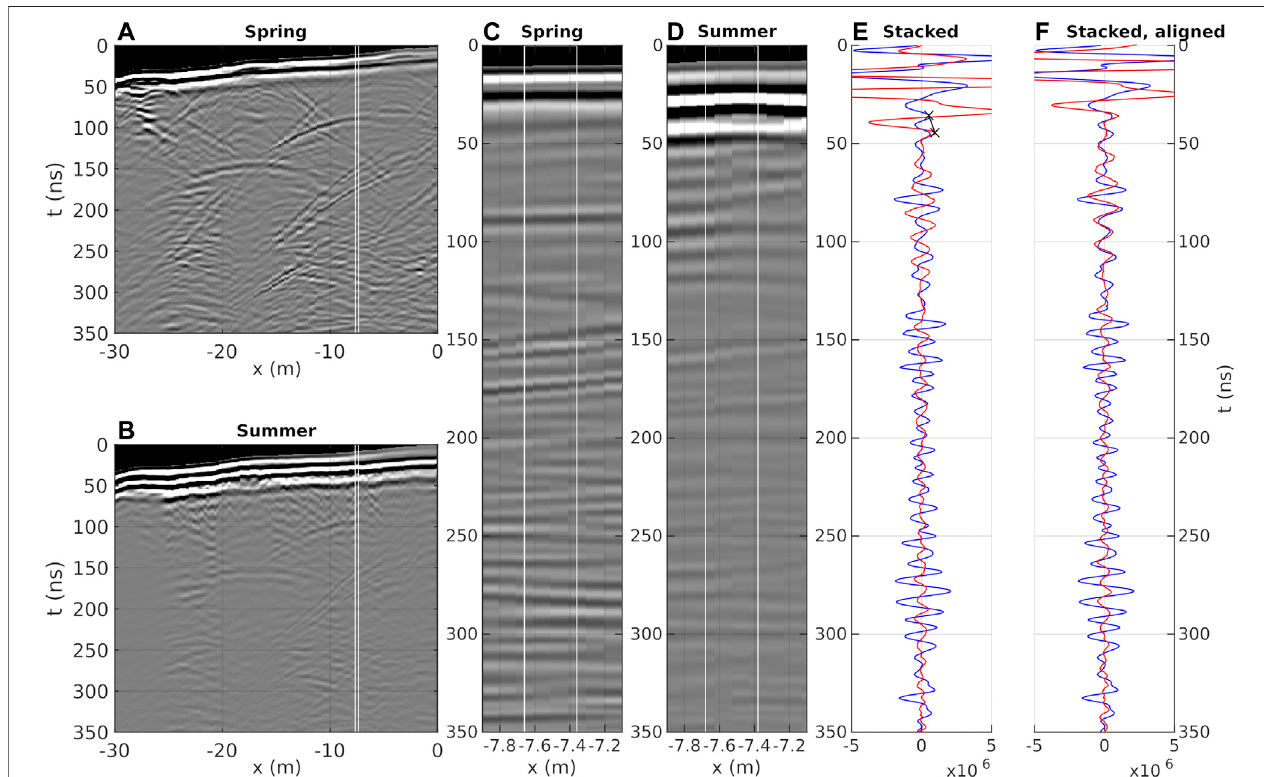
FIGURE 5 | Comparison of stacked traces extracted from gridded pro fi le data after amplitude scaling using a t 2 -scaling function. From left to right: 2D pro fi le recorded (A) in spring and (B) in summer. Zoom-ins to illustrate the data used for stacking (indicated by the white box) of (C) the spring data and (D) the summer data. (E) Stacked trace of spring (blue) and summer data (red). (F) Trace-to-trace comparison after alignment at the 50 ns re fl ection event (see black crosses in e) resulting in a time shift of − 9 ns. The shown time window of 350 ns corresponds to a depth interval of ~30 m depth for v = 0.17